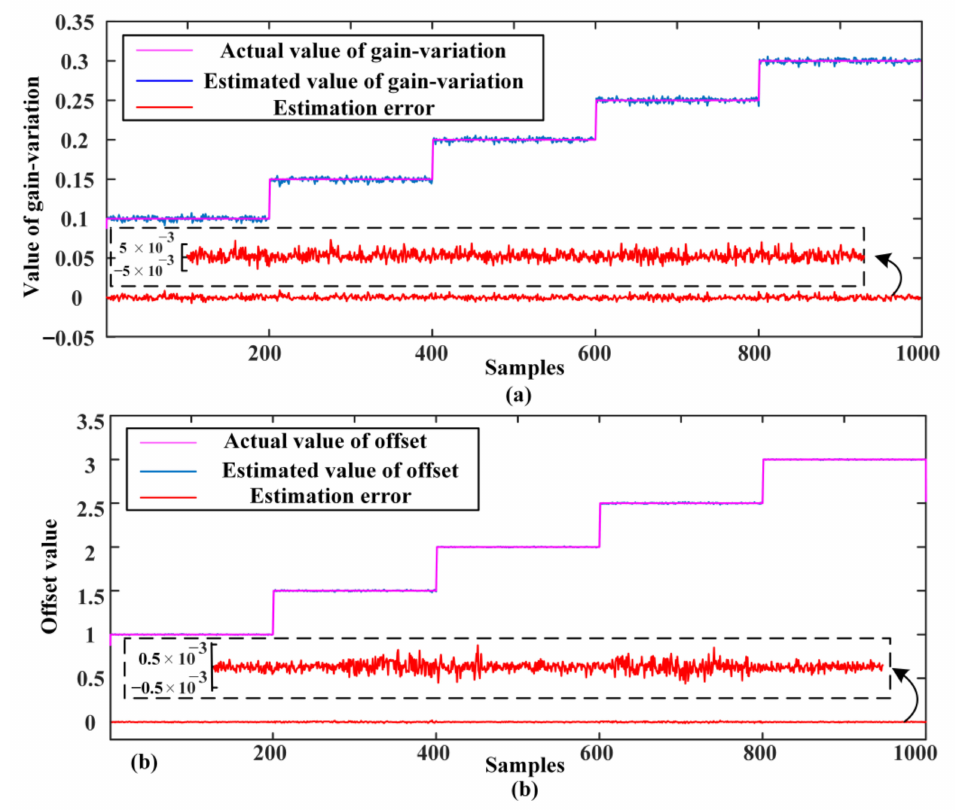
Figure 10. Estimation results of sensor faults: ( a ) estimation results of gain-variation fault; ( b ) estimation results of zero-offset